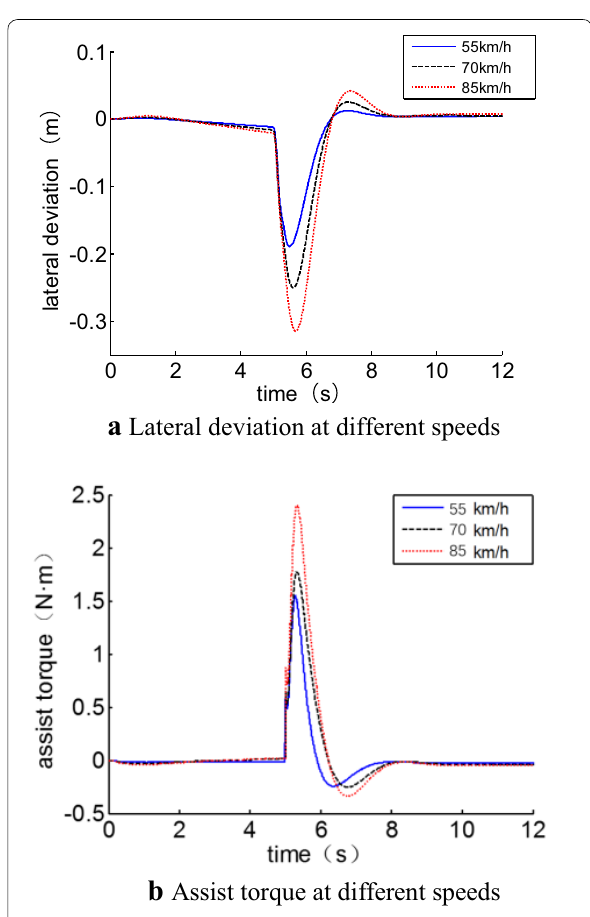
Figure 7 Vehicle information on straight road at different speeds